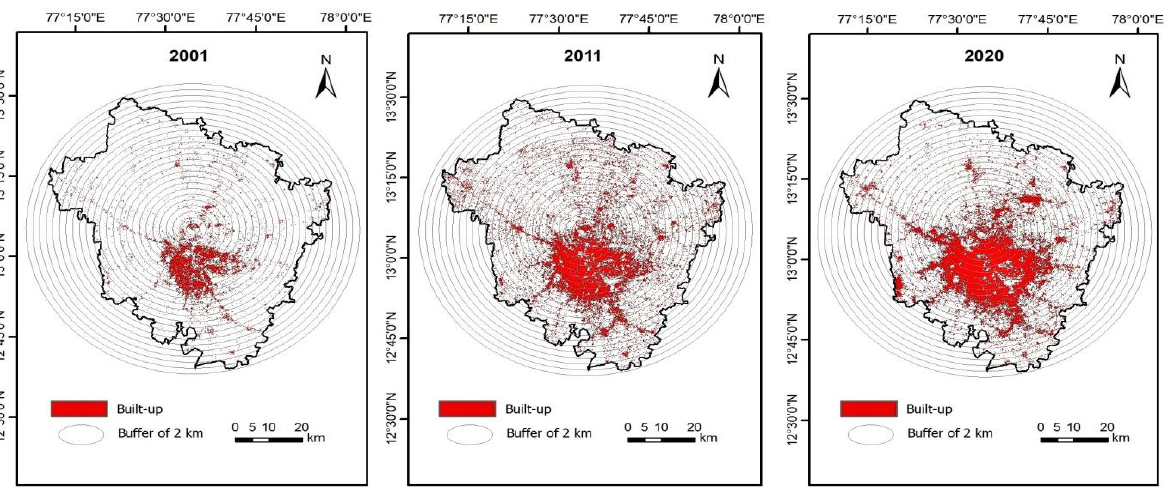
Figure 7. Spatial distribution of LULC in Bengaluru.